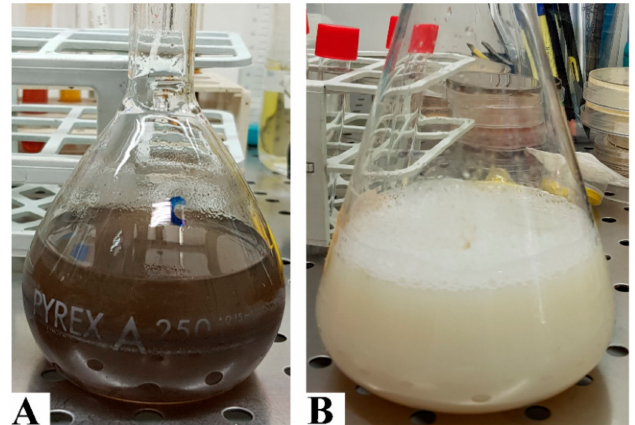
Figure 1. Biosynthesis of silver nanoparticles. Plant-mediated method ( A ) after dissolving C. longa powder in ddH 2 O, the solution was filtered to remove the majorities of vegetal debris; finally, silver nitrate was added and the change in colour was monitored. Bacterial supernatant method ( B ). After growing E. coli ATCC ® 25922 in Mueller-Hinton broth, the supernatant was collected, and silver nitrate was added to induce nanoparticle